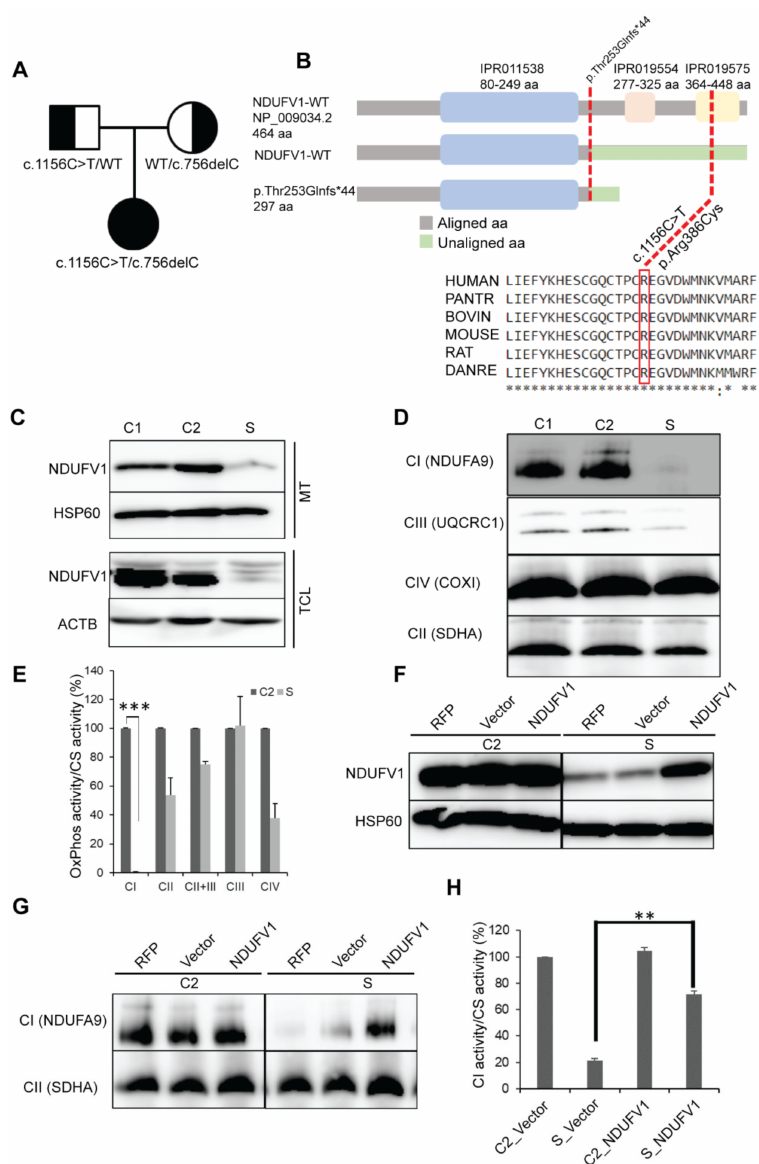
Figure3. NDUFV1 mutationsdetectedinasubject. ( A )Segregationofthefamilyshowingtheinheritance pattern of the variants. ( B ) A graphical representation of NDUFV1 with domains illustrating the position of mutations (red dotted lines) (not to scale). Mutalyzer 2.0.32 (https: // mutalyzer.nl / name-checker) for truncated protein prediction, InterPro database (https: // www.ebi.ac.uk / interpro / protein) for protein domain prediction, and ClustalW (http: // www.ebi.ac.uk / clustalw2) for amino acid (aa) alignment were used. Asterisks (*) indicates conserved aa; IPR011538, NADH: ubiquinone oxidoreductase 51kDa subunit, FMN-binding domain; IPR019554, Soluble ligand binding domain; IPR019575, NADH: ubiquinone oxidoreductase 51kDa subunit, iron-sulfur binding domain. ( C ) SDS-PAGE immunoblotting of mitochondrial (MT) and total cell lysate (TCL) showing loss of NDUFV1 protein in the subject (S) compared with controls (C1, fHDF; C2, NHDF). HSP60 and ACTB were used as loading controls. ( D ) BN-PAGE immunoblotting showing destabilization of CI assembly in S. Complex II was used as loading control. ( E ) OxPhos enzymology revealed CI enzyme deficiency in S compared to C2. Values are expressed as the mean ± SEM. Three independent experiments, two tailed student’s t test done and *** p < 0.001 considered statistically significant. ( F – H ) Lentivirus-mediated complementation assays showing: ( F ) restoration of the NDUFV1 protein in S; ( G ) stabilization of CI assembly; ( H ) restoration of CI enzyme activity. Values are expressed as the mean ± SEM. Three independent experiments, ** p < 0.01 considered statistically significant RFP, mtTurbo-RFP; Vector,